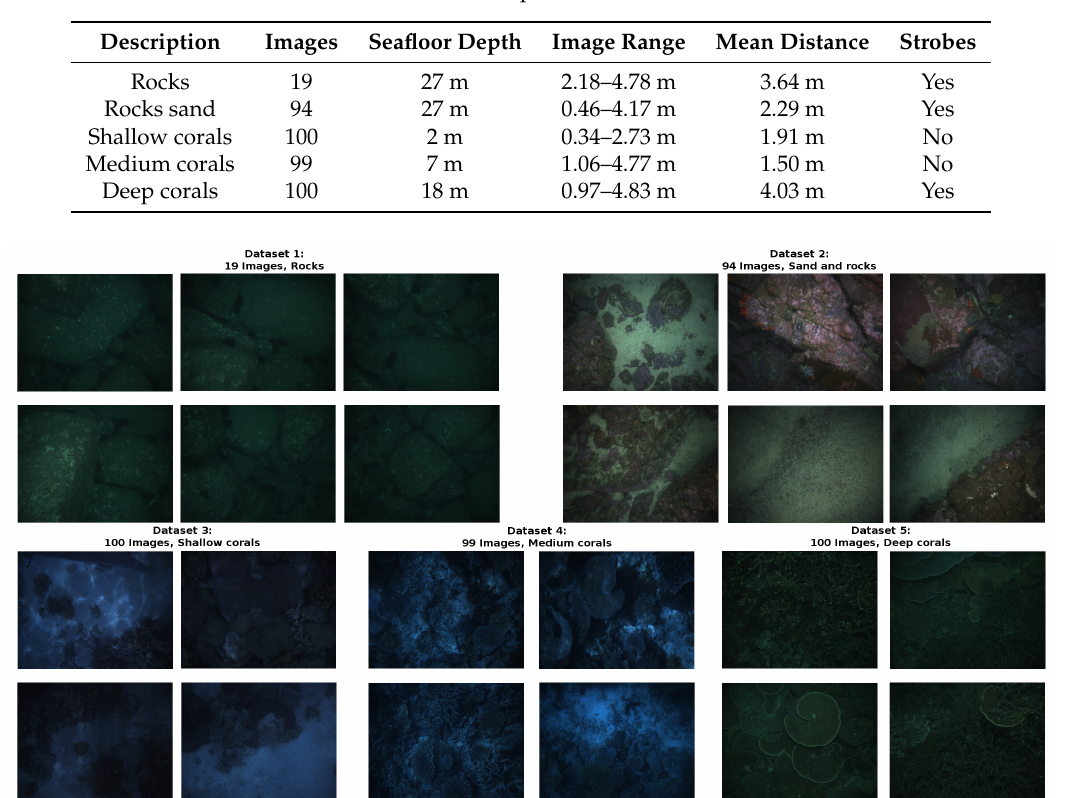
Figure 3. Images of the different datasets used in the